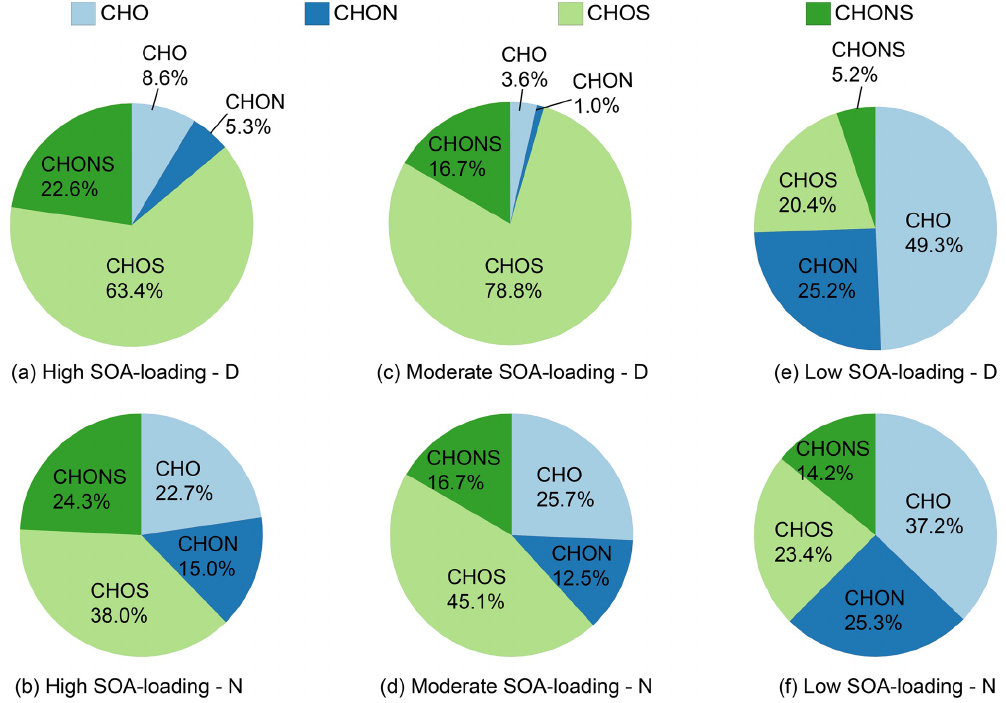
Figure 2. Comparison of molecular elemental types of all PM 2 . 5 samples. The pie chart shows the percentage of the different compound groups in various samples by intensity.